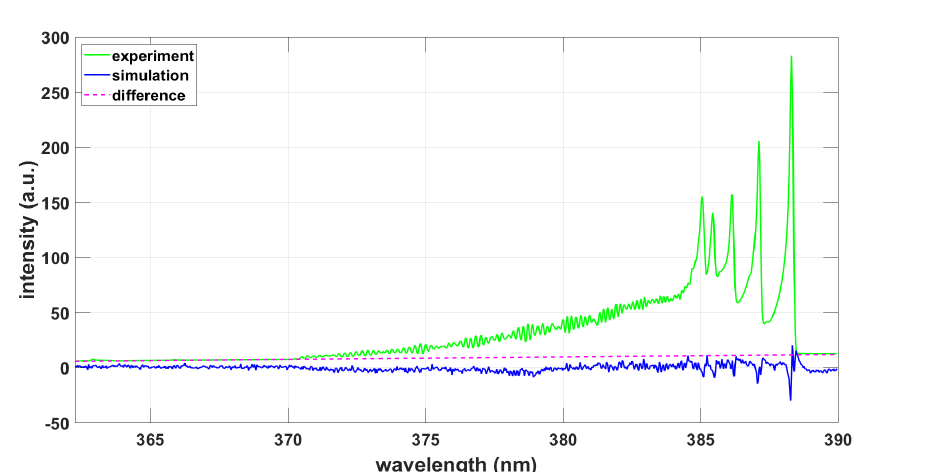
Figure 7. Simulation using PGOPHER data and the NMT program, T = 8380 K, ∆ λ = 0.11 nm. Fitting the ExoMol data using the NMT program yields a temperature of T = 9090 K for a spectral resolution of ∆ λ = 0.11 nm. Figure 8 illustrates the simulated spectrum, difference and baseline.